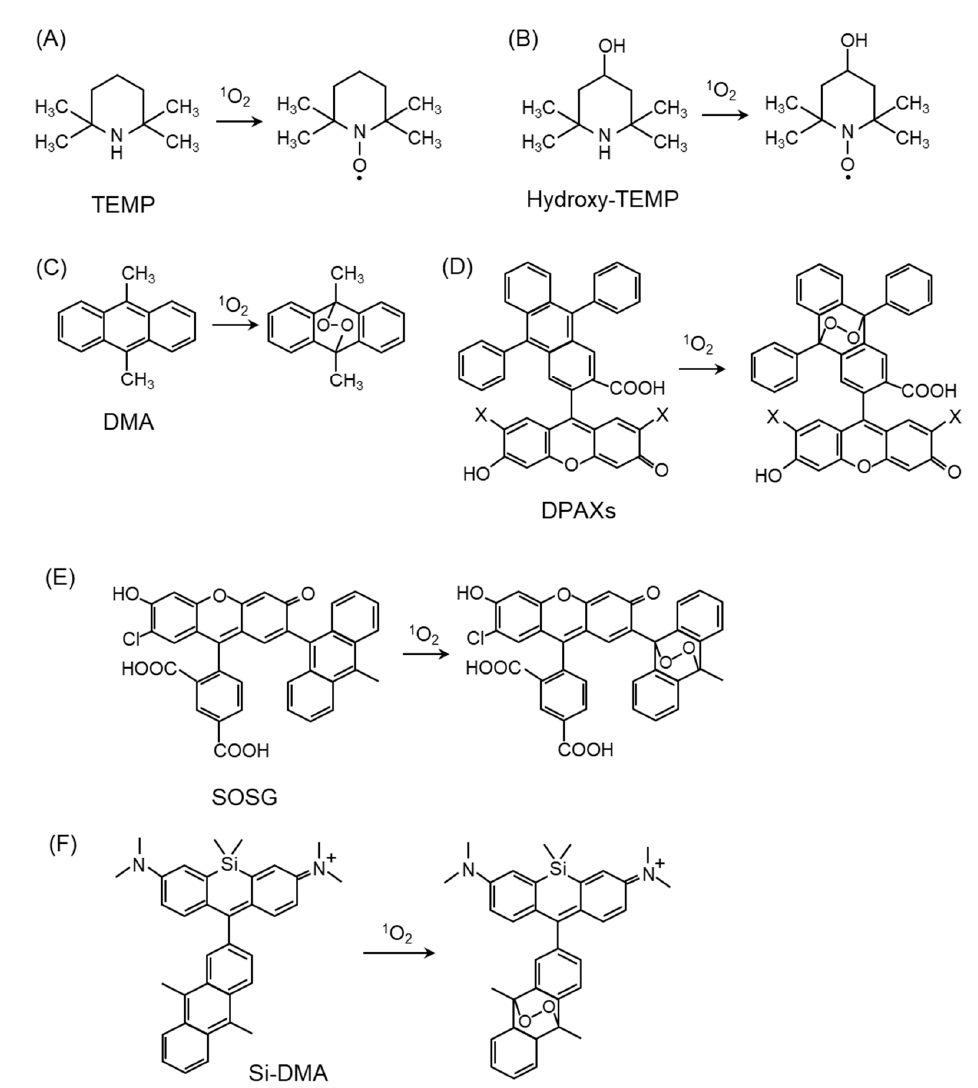
Figure 4. Structures and oxidation modification of probes for 1 O 2 detection. ( A ) 2,2,6,6- tetramethylpiperidine (TEMP), ( B ) Hydroxy-TEMP, ( C ) 9,10-dimethylanthracene (DMA), ( D ) 9- [2-(3-Carboxy-9,10-diphenyl)anthryl]-6-hydroxy-3H-xanthen-3-ones (DPAXs), ( E ) Singlet Oxygen Sensor Green (SOSG), ( F ) silicone-containing rhodamine-9,10-dimethylanthracene